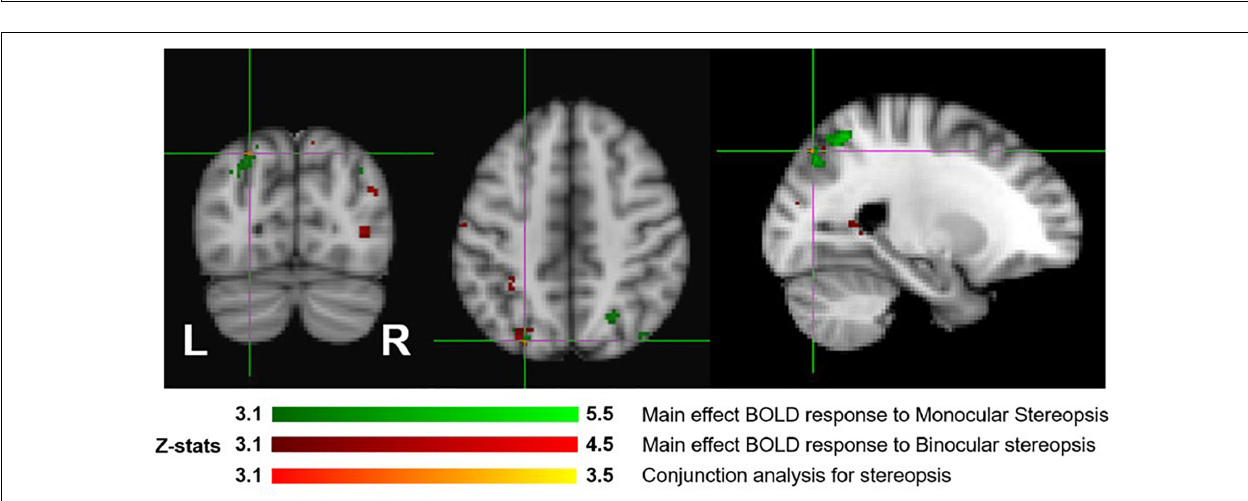
FIGURE 7 | Group results ( N = 7) for monocular (green) and binocular (red) stereopsis, and conjunction analysis for monocular and binocular stereopsis (red-yellow), revealed by the fMRI fixed effects results. The main effects are masked to gray matter. Uncorrected p < 0.001. The crosshairs represent the significantly overlapping region between monocular and binocular stereopsis [MNI coordinates: − 24, − 76, and 46].